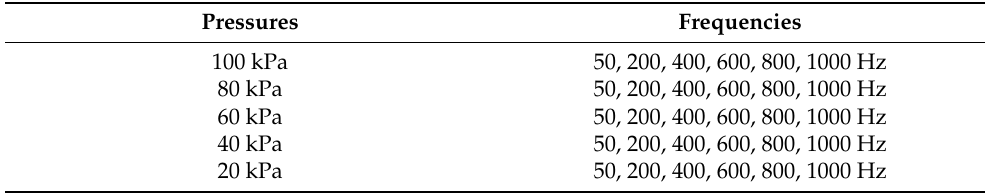
Table 1. Tests performed (three consecutive repetitions each test).